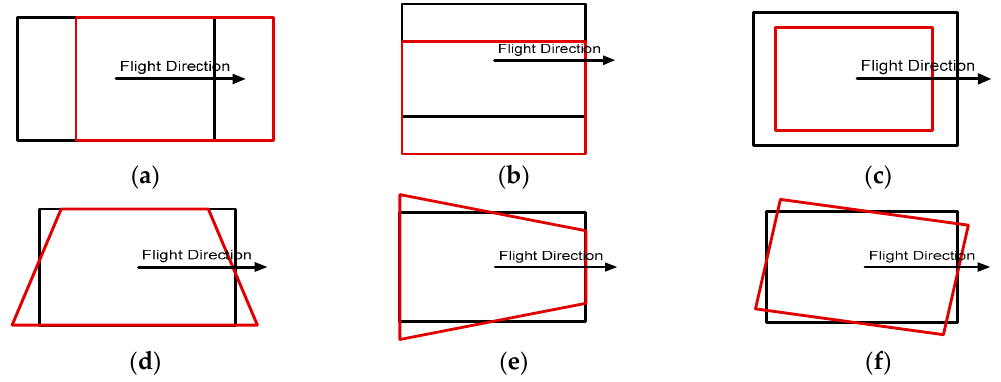
Figure 14. The behaviors caused by errors for EOP parameters: ( a ) X 0 ; ( b ) Y 0 ; ( c ) Z 0 ; ( d ) ω 0 ; ( e ) ϕ 0 ; and ( f ) κ 0